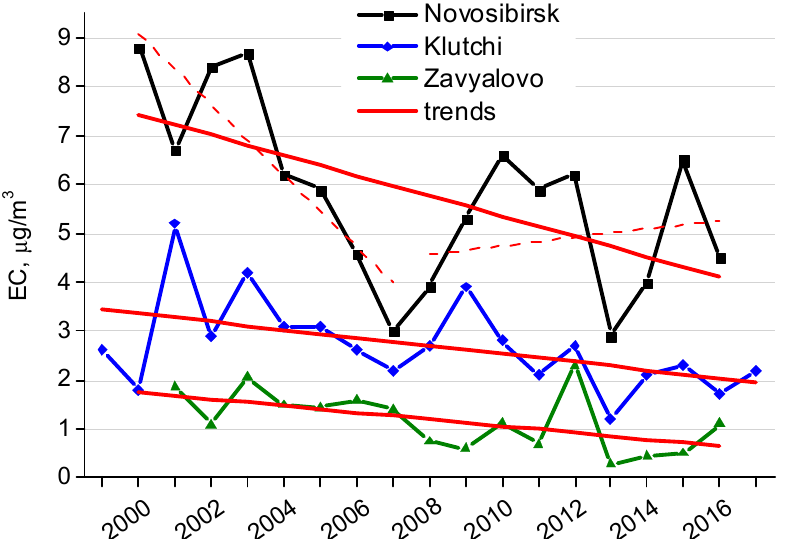
Figure 9. Multiyear (1999–2017) behavior of annual average EC concentrations and their trends (solid lines) in Novosibirsk (urban center), Klutchi village (suburban), and Zavyalovo village (background). Dashed lines show EC concentration trends in Novosibirsk during 1999–2007 and 2008–2016.